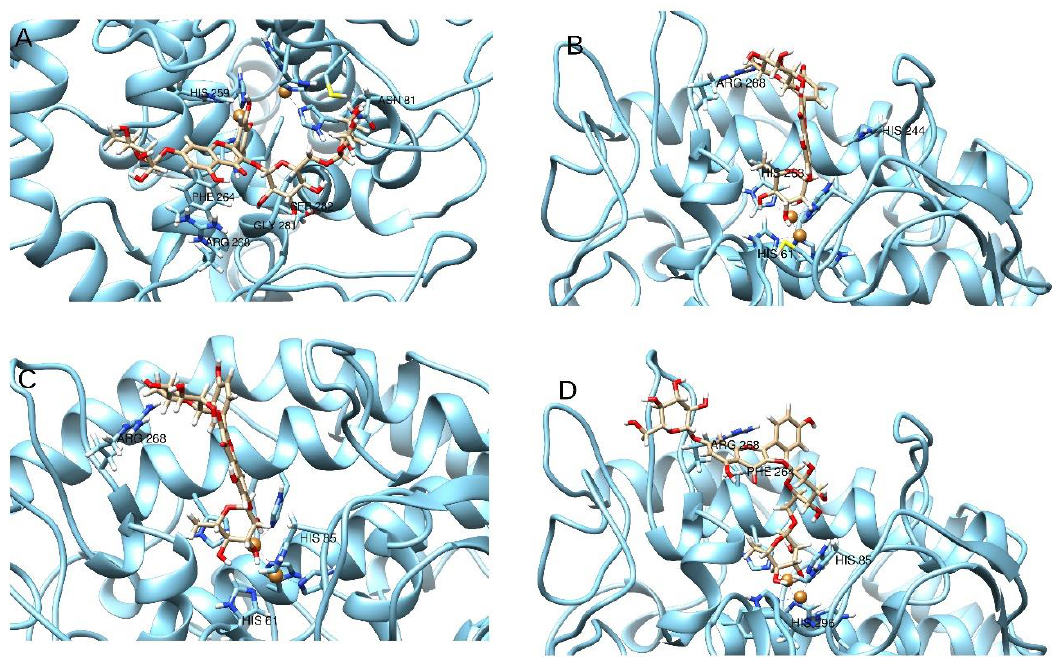
Figure 3. Three-dimensional (3D) best poses of compounds 11 (quercetin-di-Hex-dHex) ( A ), 12 : quercetin-Hex-dHex ( B ), 13 : Kaempferol-Hex-Rut ( C ), and 14 : kaempferol-dHex-Hex ( D ), identified in the sea rocket ( Cakile maritima ) extracts, docked to tyrosinase.